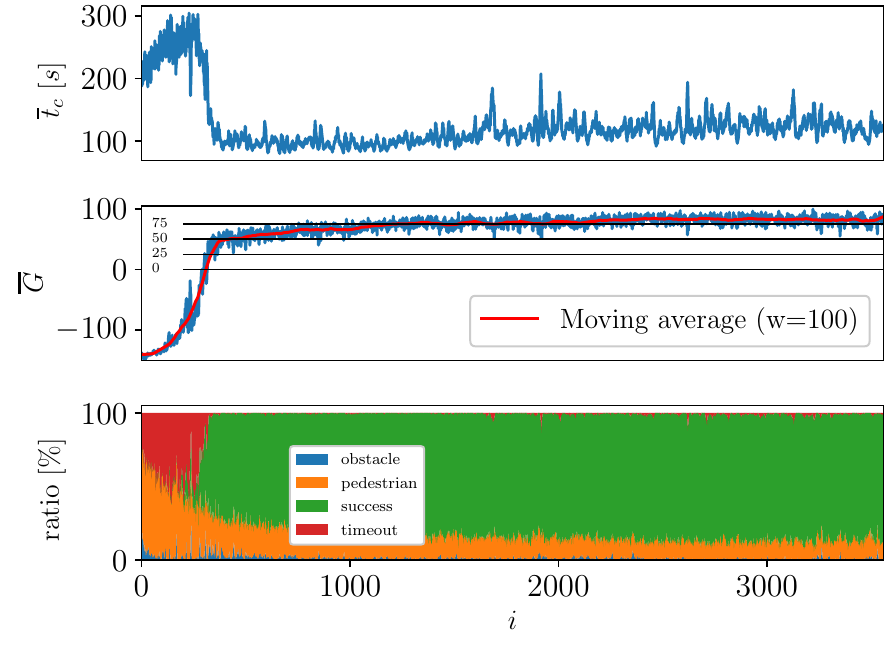
Figure 12. Summary of the A3C performance: in the top row the evolution of the average of the duration of the single simulation run t c ; in the middle row the evolution of the average of the cumulative reward G ; in the bottom row the evolution of the statistic of the simulation termination reason